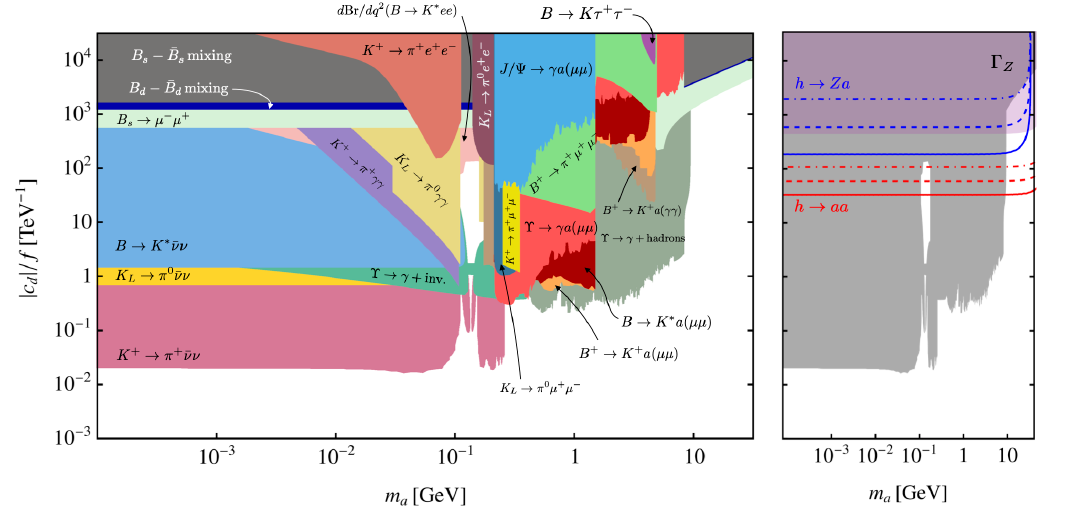
Figure 24 . Left; flavor bounds on universal ALP couplings to down-type quarks with c d = c d 1 , with all other Wilson coefficients set to zero at Λ = 4 πf and f = 1 TeV. Right: constraints from flavor observables (light gray) are compared to the constraint on Z → aγ decays from the LEP measurement of the Z boson width. Contours of constant Br ( h → aa ) = 10 − 1 , 10 − 2 and 10 − 3 are depicted as red dotted, dashed and solid lines, respectively. Contours of constant Br ( h → Za ) = 10 − 1 , 10 − 2 and 10 − 3 are shown as blue dotted, dashed and solid lines,